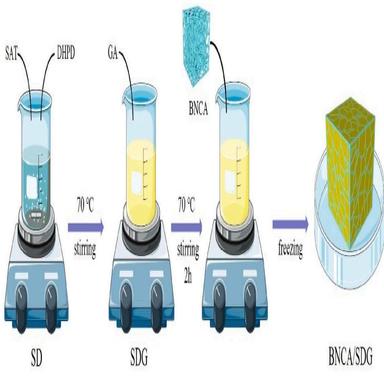
The fabrication process of BNCA/SDG composite PCMs.